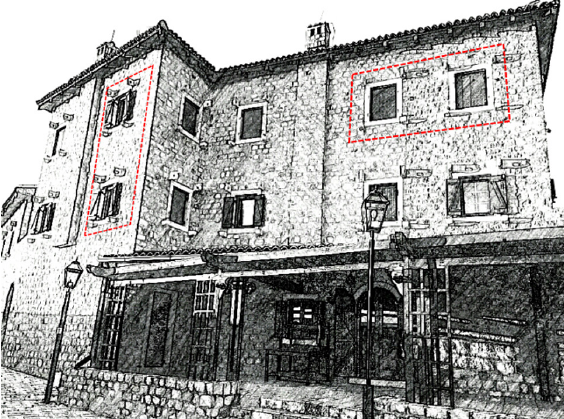
Fig. 6. old house, old structure of the city castle.